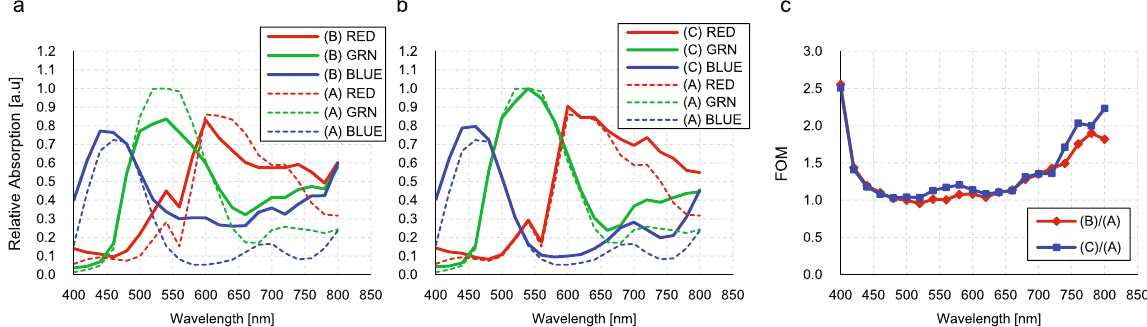
Figure 4. ( a ) FDTD simulation results of Samples A and B shown in Fig. 3. Dashed RGB lines show the normalized amount of the light absorptions of RGB pixels of Sample A. Here the amount of peak absorption of green pixel is assumed to be 1.0 for normalization. Solid RGB lines show the amount of light absorption of RGB pixels of sample B. ( b ) Simulation results of Sample A with dashed lines and sample C with solid lines. ( c ) Figure of Merit, the normalized amount of absorption by sample A. The red diamond is the ratio between sample B and sample A, and the blue square is the ratio between sample C and sample A.